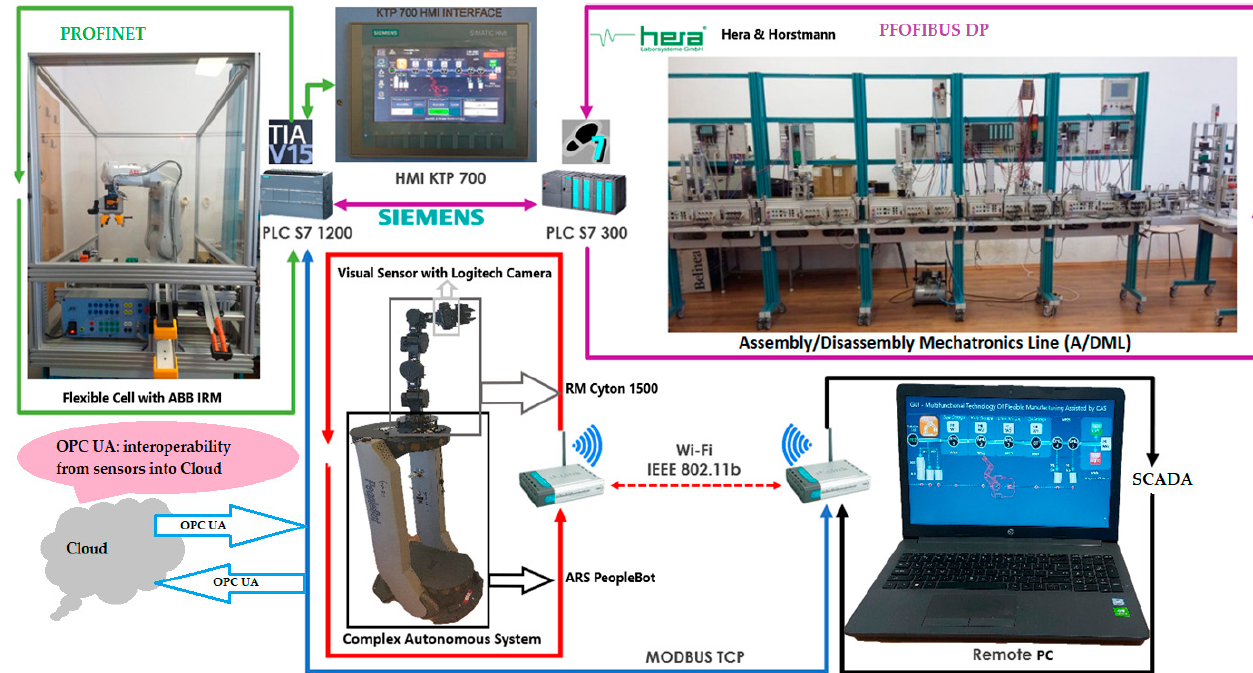
Figure 1. Control structure of A/DML Hera & Horstmann, FC with ABB IRM and CAS with PeopleBot WMR, and Cyton 1500 RM.